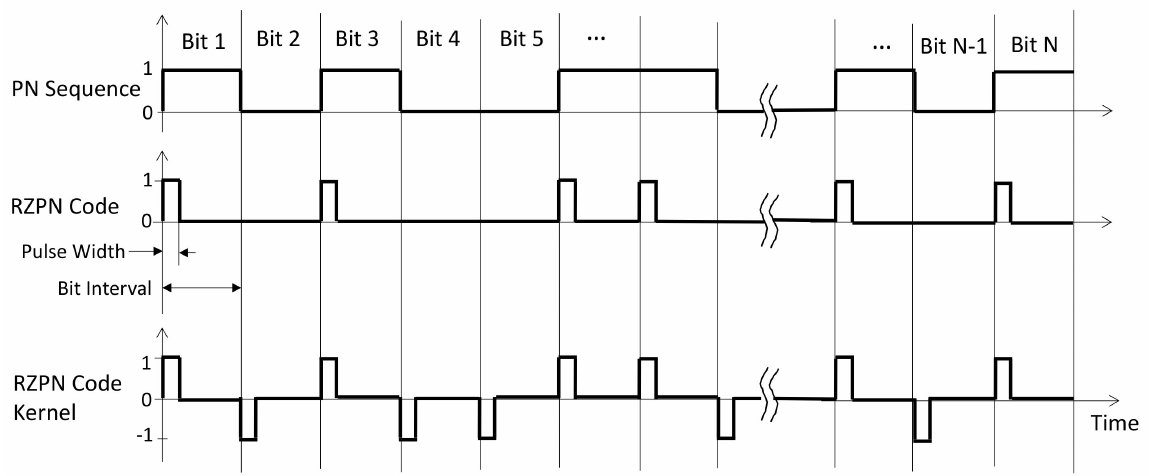
Figure 1. Schematic of a binary PN sequence ( top ), the corresponding RZPN code for the laser modulation ( middle ), and the kernel to be used for the correlation detection ( bottom